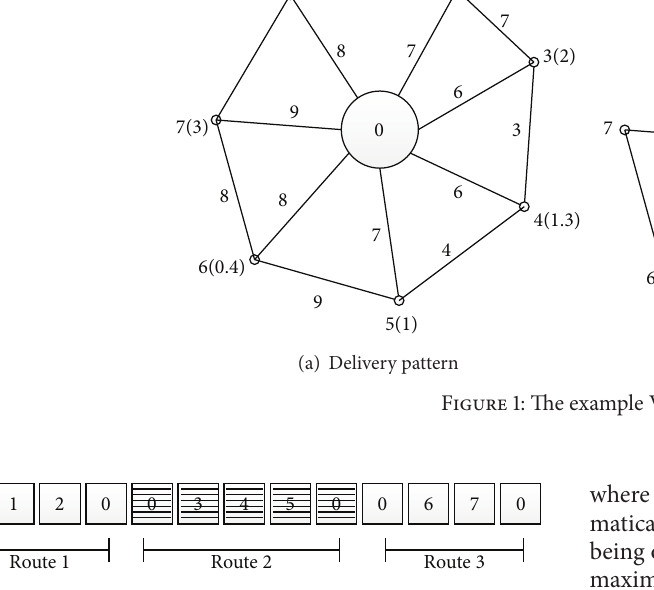
Figure 2: A chromosome